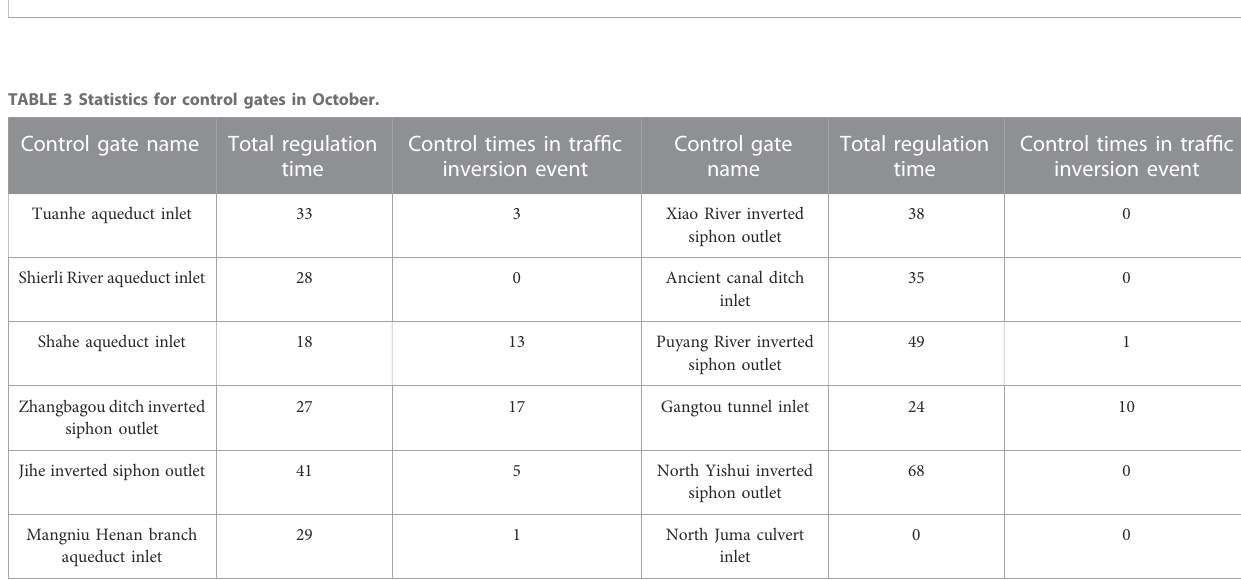
FIGURE 4 Comparison of observed fl ow and theoretical fl ow between the Chaohe control gate and Zhangbagou control gate.